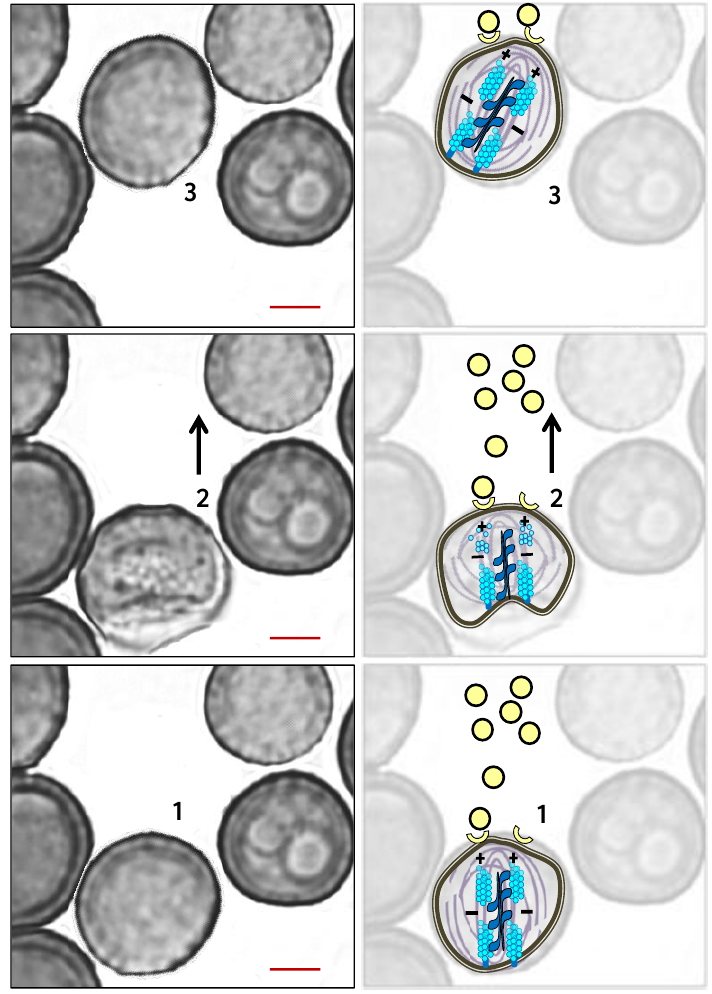
Figure 10. Schematic representation (on the right) superimposed on a real image (on the left) that demonstrates the role of the cytoskeleton in teliospore motility. The binding of the quorum signal to its receptors (1) induces polar cell invagination (2), which is produced by the interaction of an ATPase with contractile ability, which is sensitive to blebbistatin, with F-actin cytoskeleton. After this, the depolymerization of F-actin is achieved at the opposite pole, the repolymerization of which produces the cell advancement (3). Throughout this process, microtubules (MTs) are reorganized in cells to collaborate in the displacement with F-actin filaments. Scale bars indicate 2 µm.